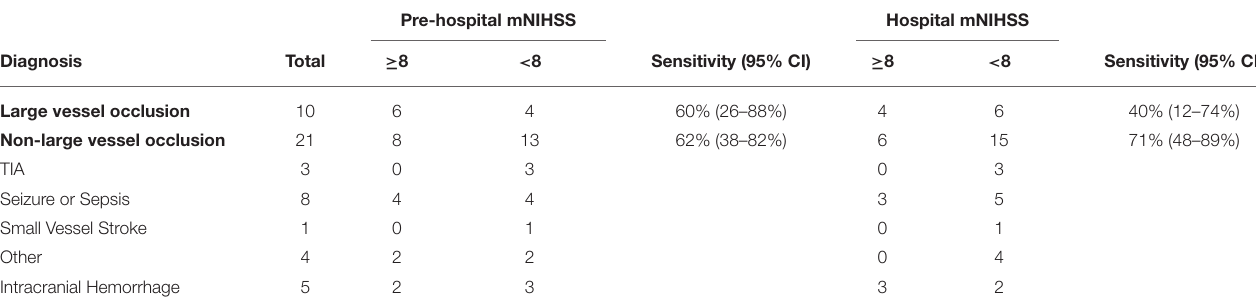
TABLE 2 | Performance assessment of pre-hospital and hospital modified National Institutes of Health Stroke Scale (mNIHSS) at predicting large vessel occlusions. Pre-hospital mNIHSS Hospital